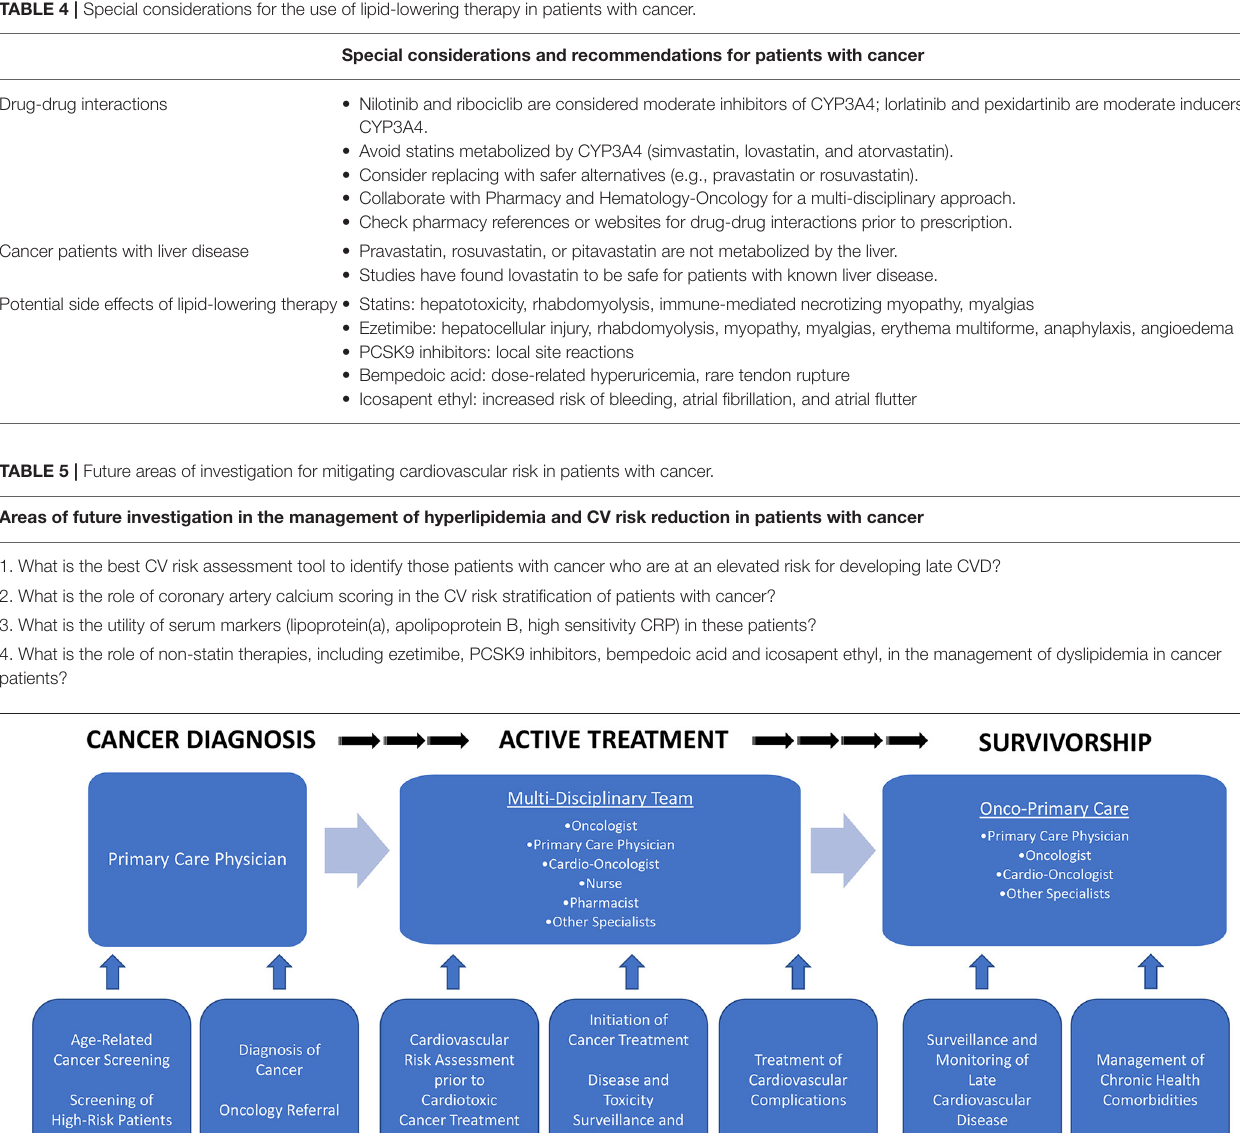
TABLE 4 | Special considerations for the use of lipid-lowering therapy in patients with cancer.